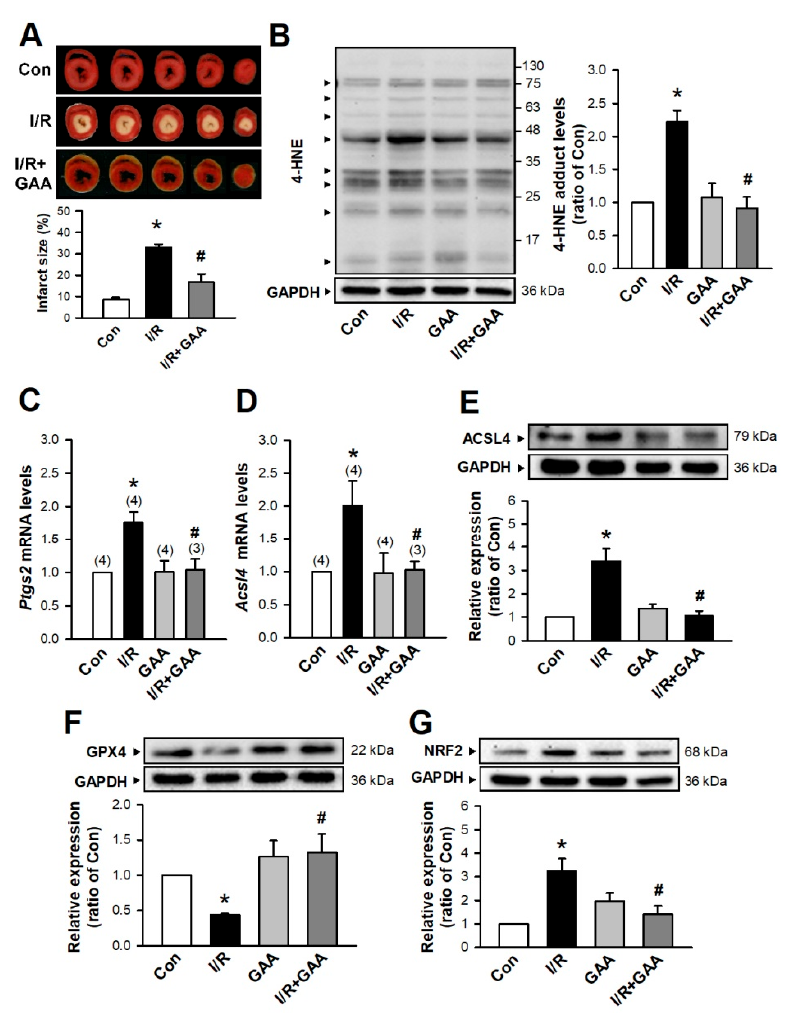
Figure 7. The mechanism by which GAA attenuates myocardial I/R-induced ferroptotic cell death in ex vivo rat hearts. ( A ) Representative images (Top) and quantitative data (Bottom) showed that GAA (5 µ M) significantly reduced the I/R-induced increase in myocardial infarct size (n= 3). ( B ) Cotreatment with I/R and GAA (10 µ M) significantly decreased the 4-HNE adduct levels (n= 4). GAA significantly decreased levels of Ptgs2 ( C ) and Acsl4 ( D ) mRNA in myocardial ischemia-treated hearts according to quantitative PCR analysis. Values shown in parenthesis represent the number in each group. ( E ) Treatment with GAA significantly inhibited the I/R-increased levels of ACSL4 protein enhancement (n = 9). ( F ) Treatment with GAA increased GPX4 protein levels compared with those observed in the I/R-treated group (n = 9). ( G ) Treatment with GAA significantly inhibited I/R-increased levels of NRF2 protein (n = 6). All data represent means ± SEM. * p < 0.05 versus the control group; # p < 0.05 versus I/R. Con, control; I/R, ischemia/reperfusion; GAA, gossypol acetic acid.